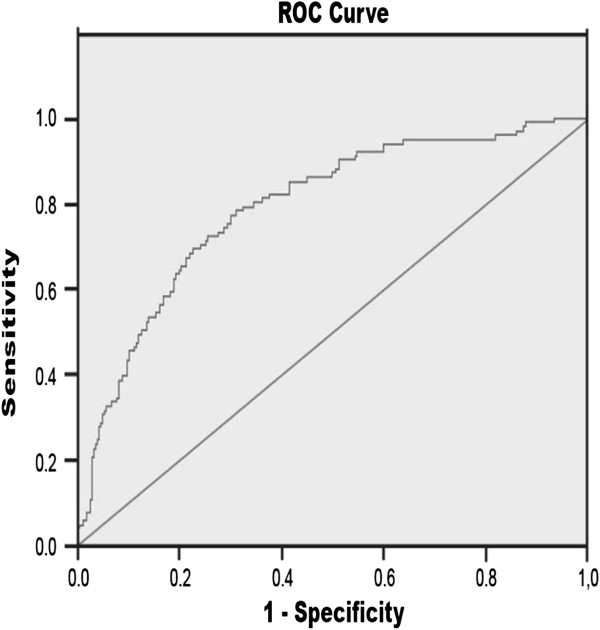
Receiver operator characteristic (ROC) curve showing the sensitivity and specificity of the model incorporating eGFR, HB and gender to predict development of anaemia within the 3-year follow-up period.